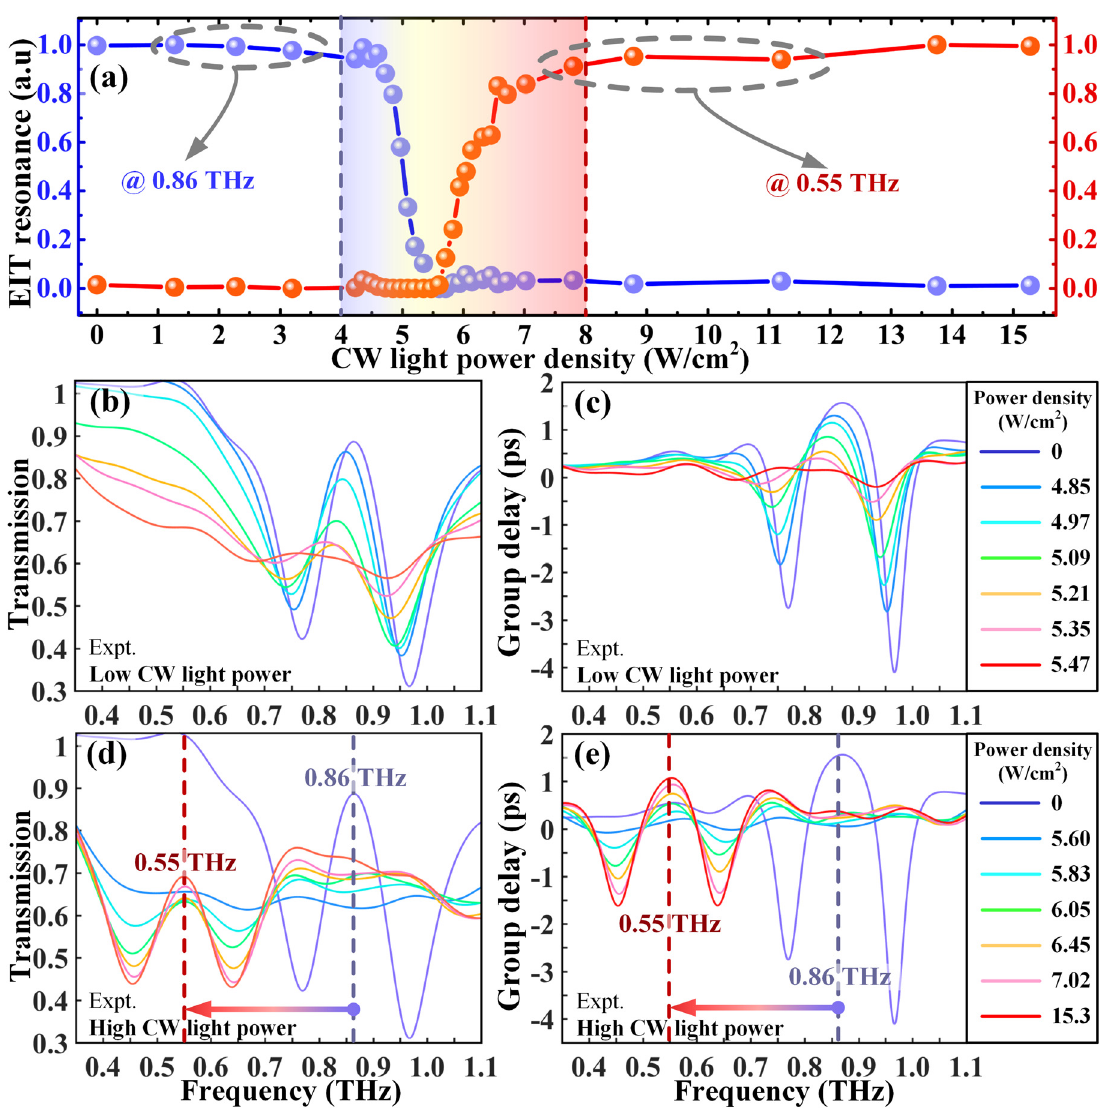
Figure 2: Experimental demonstration of THz spectrum responses as the CW light induced molecularization occurs. (a)MeasuredtransmissionamplitudeofthenormalizedEITresonancestrengthwiththeappliedCWlightdensityrangingfrom0to15.3W/cm 2 for the EIT peak centered at 0.86 THz (blue curve) and 0.55 THz (red curve), respectively. Experimental (b) transmission and (c) group delay spectra of the metadevice with a low CW light power ranging from 0 to 5.47 W/cm 2 , leading to the disappearance of the EIT resonance at 0.86THz.(d)and(e)Incontrast,thecorrespondingTHzdispersionspectrainthehighCWlightpowercasefrom5.6to15.3W/cm 2 demonstrate the formation of a new EIT resonance at 0.55 THz, resulting in the molecularization of metaatoms and broadband resonance frequency